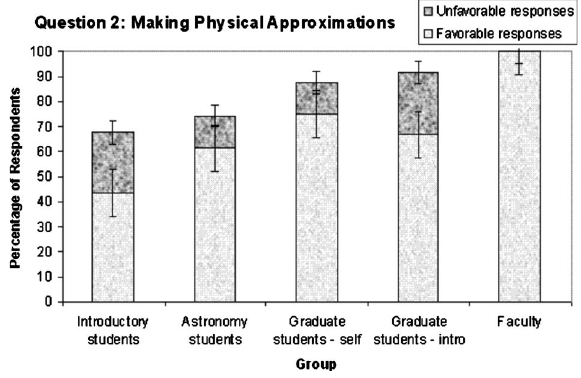
FIG. 8. Histogram showing favorable (cid:1) agree (cid:2) and unfavorable (cid:1) disagree (cid:2) responses for survey question (cid:1) 2 (cid:2) . The histogram shows that all faculty agreed that they often make approximations about the physical world but other respondents, including physics gradu- ate students, were not always in agreement.